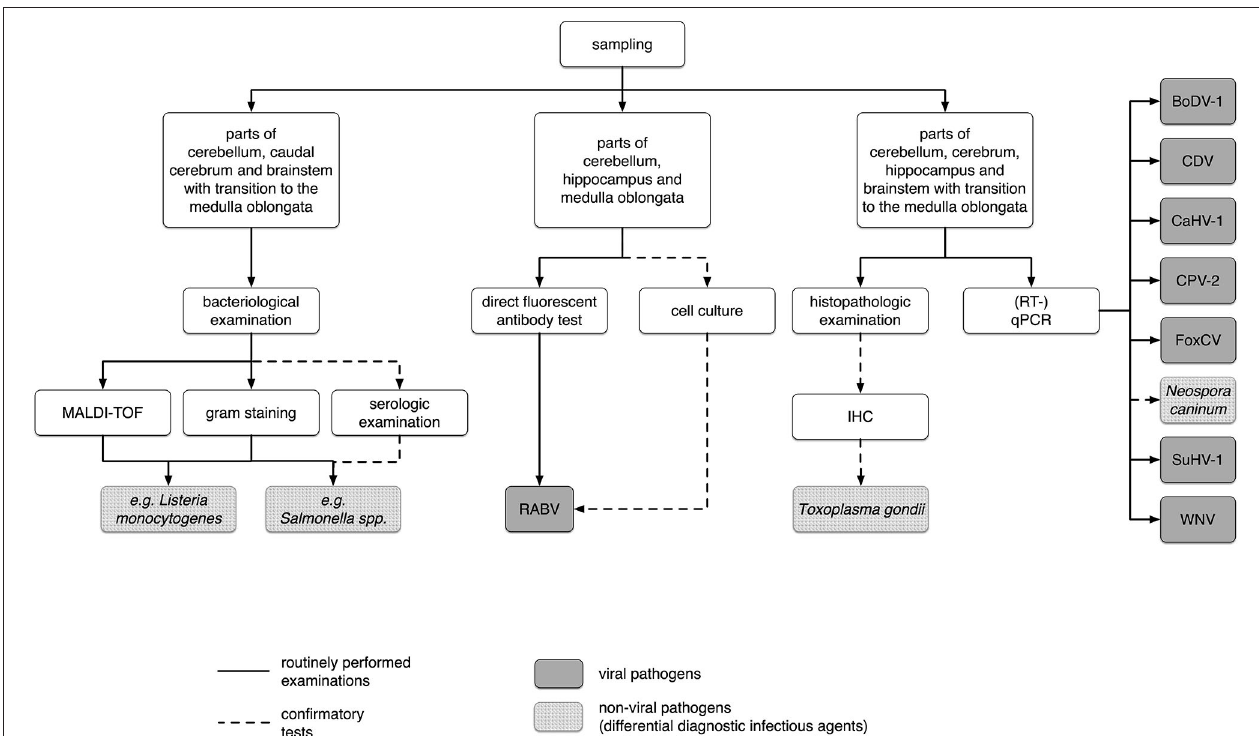
FIGURE 1 | Scheme of all samples used and examinations performed in this study. BoDV-1, Borna disease virus 1; CDV, canine distemper virus; CaHV-1, canid alphaherpesvirus 1; CPV-2, canine parvovirus type 2, 2a, 2b, or 2c; FoxCV, fox circovirus; IHC, immunohistochemistry; MALDI-TOFF, matrix-assisted laser desorption/ionization-time of flight mass spectrometry; (RT-)qPCR, (reverse transcription) quantitative polymerase chain reaction; RABV, rabies virus; SuHV-1, suid herpesvirus 1; WNV, West Nile